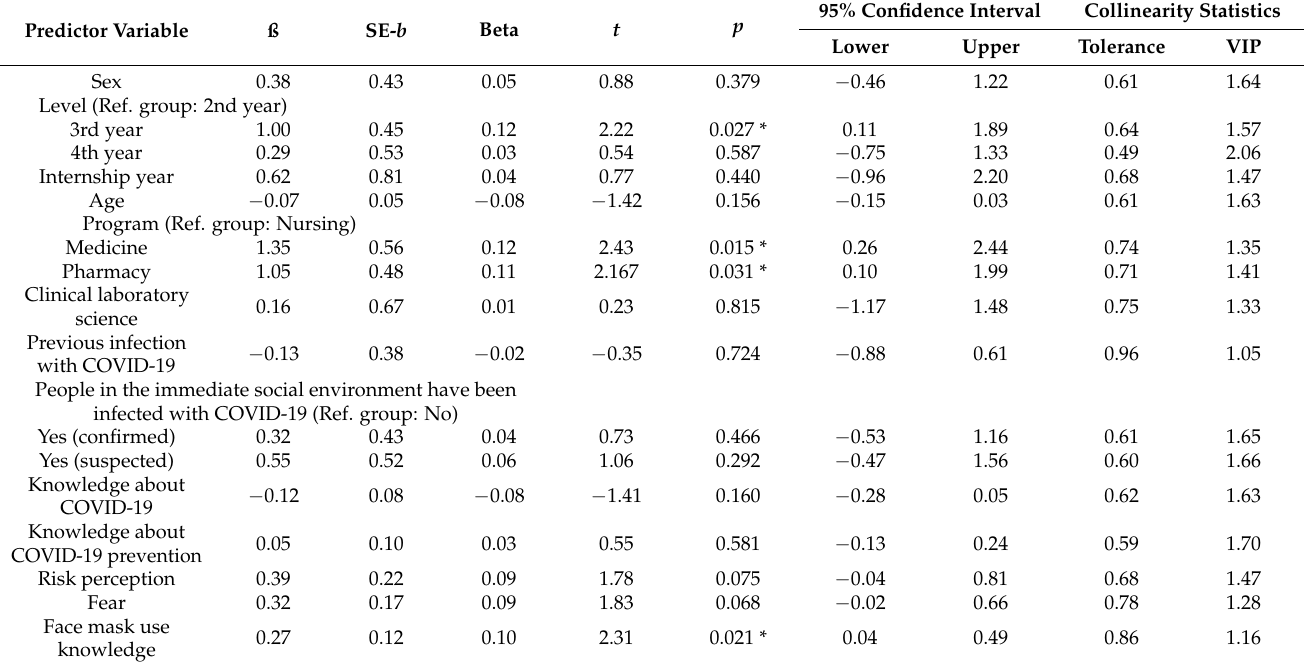
Table 3. Results of the multiple regression analysis on the students’ face mask use attitudes (n =